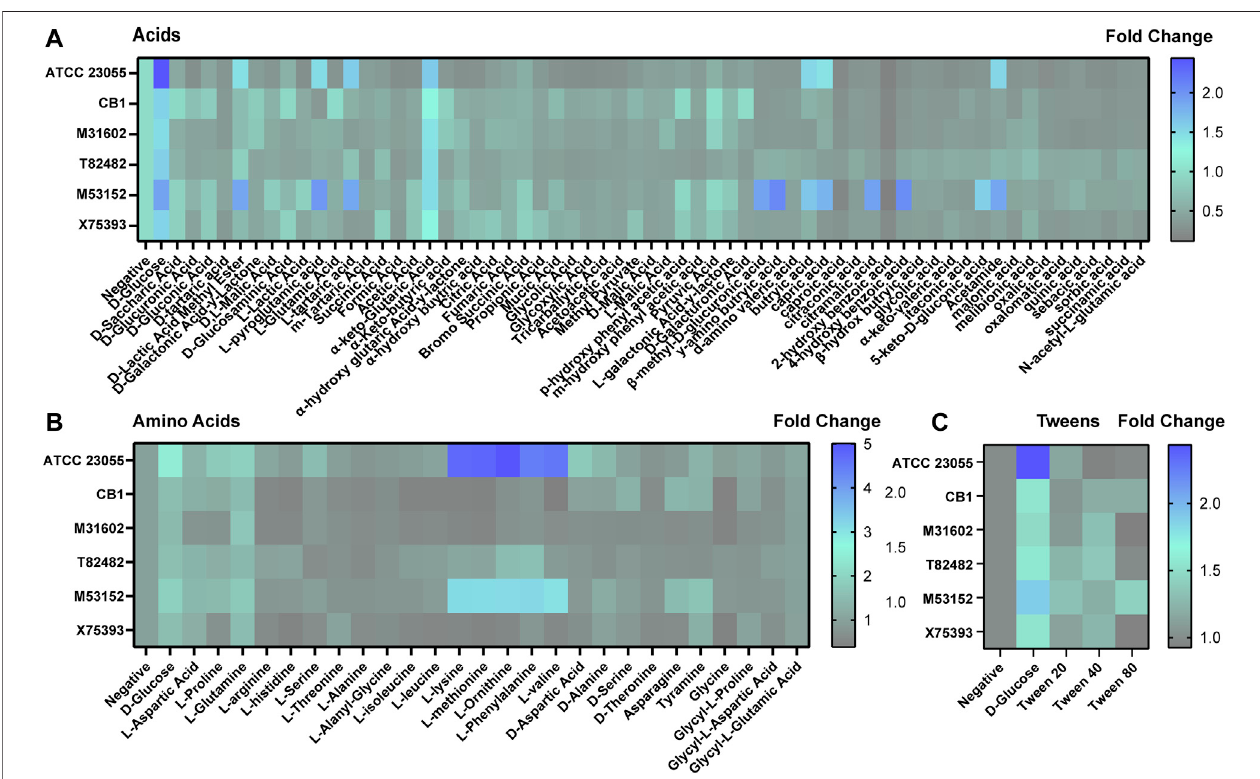
FIGURE 6 | Acinetobacter growth in acids, amino acids and tweens. Heat maps representing fold change in growth with the negative control (no added nutrients) set at 1. Growth was examined with (A) acids, (B) amino acids, and (C) tweens after 18 h incubation.